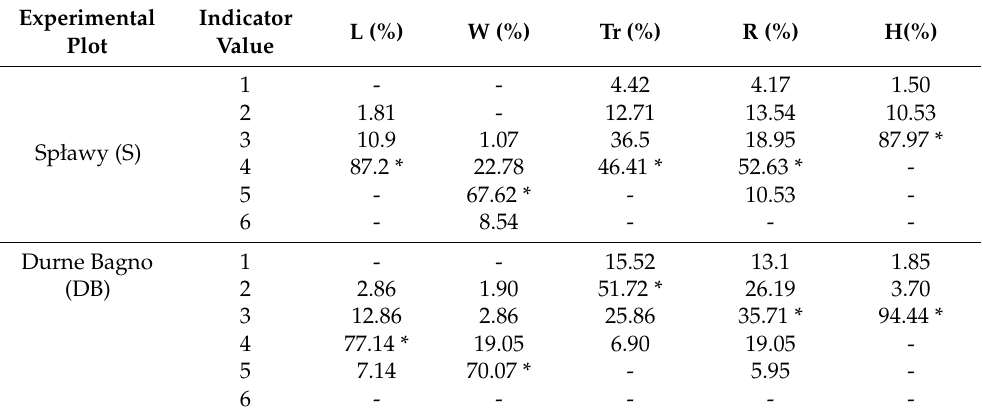
Table 2. Proportions of ecological groups of plants in the phytocenoses of the habitats (based on ecological indicator values of vascular plants: L—light value; W—soil moisture value; Tr—trophy value, R—water acidity value, H—organic matter content value; numerical designations denote assignment to specific ecological groups following Zarzycki et al., 2002 [42]). Experimental Indicator L (%) W (%) Tr (%) R (%) H(%) Plot Value 1 Spławy (S)